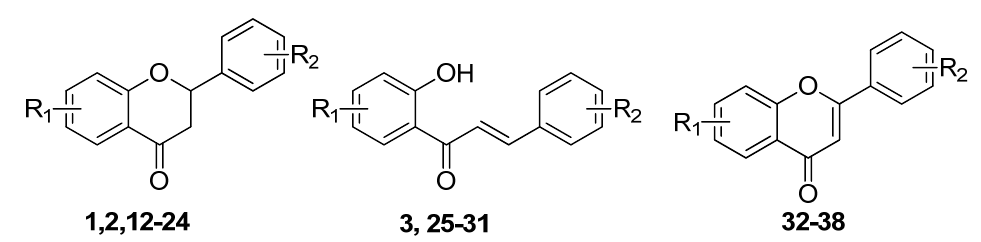
Table 4. The experimental and prediction vasorelaxant activities of flavonoids 1-3 , 10a , b , 11c-e and 12-38 used in the established QSAR